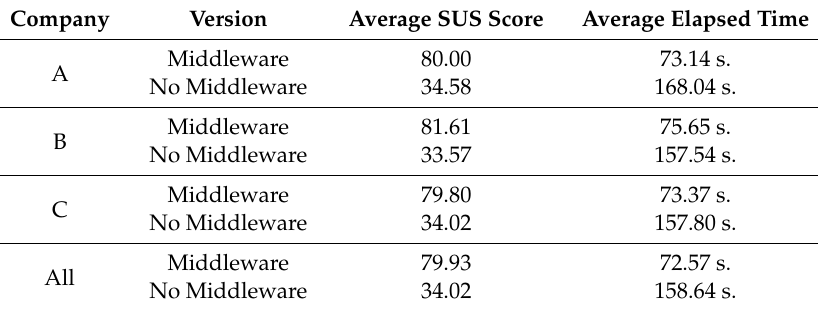
Table 6. Experiment Results per Clockchain